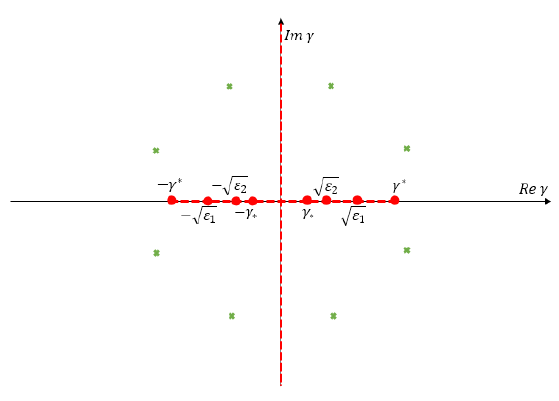
Figure 2. The spectrum of the operator-function N( γ ); × are eigenvalues of the operator-function N( γ ); • denote values of degeneration of the operator-function N( γ ); − denote points of set (cid:101) Λ